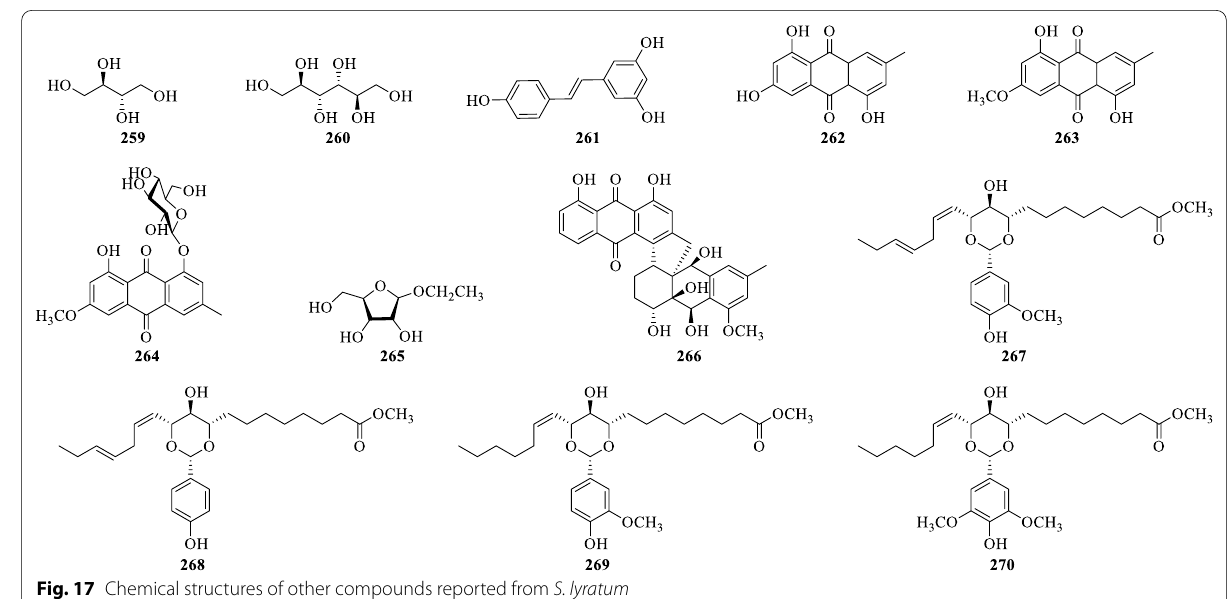
Table 12 Other compounds isolated from S. lyratum